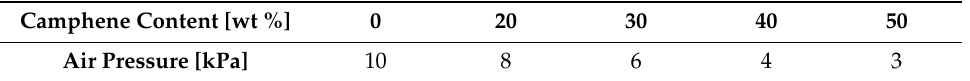
Table 1. Air pressures used to extrude PCL–camphene solutions with di ff erent camphene contents (0, 20, 30, 40, and 50